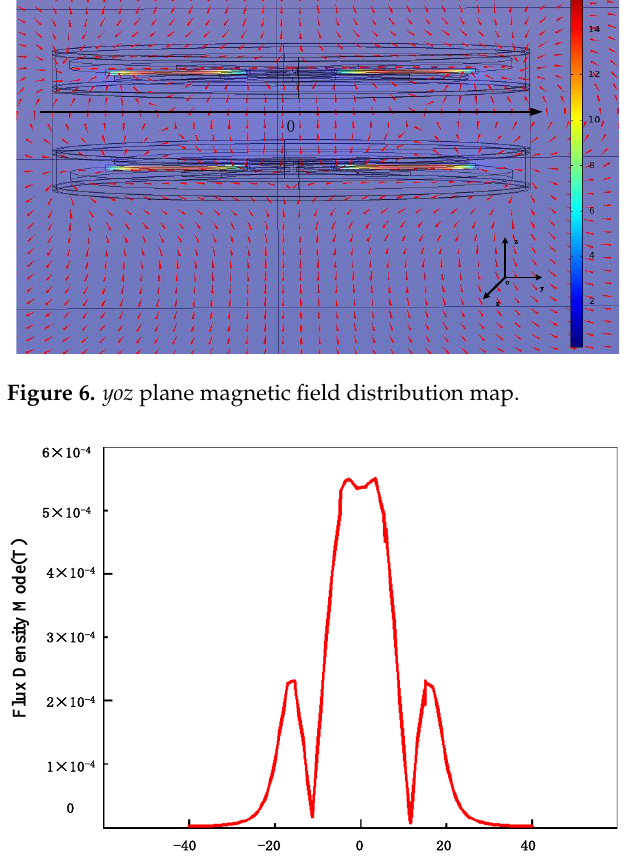
Figure 7. Magnetic field distribution on yoz plane coupling center line.